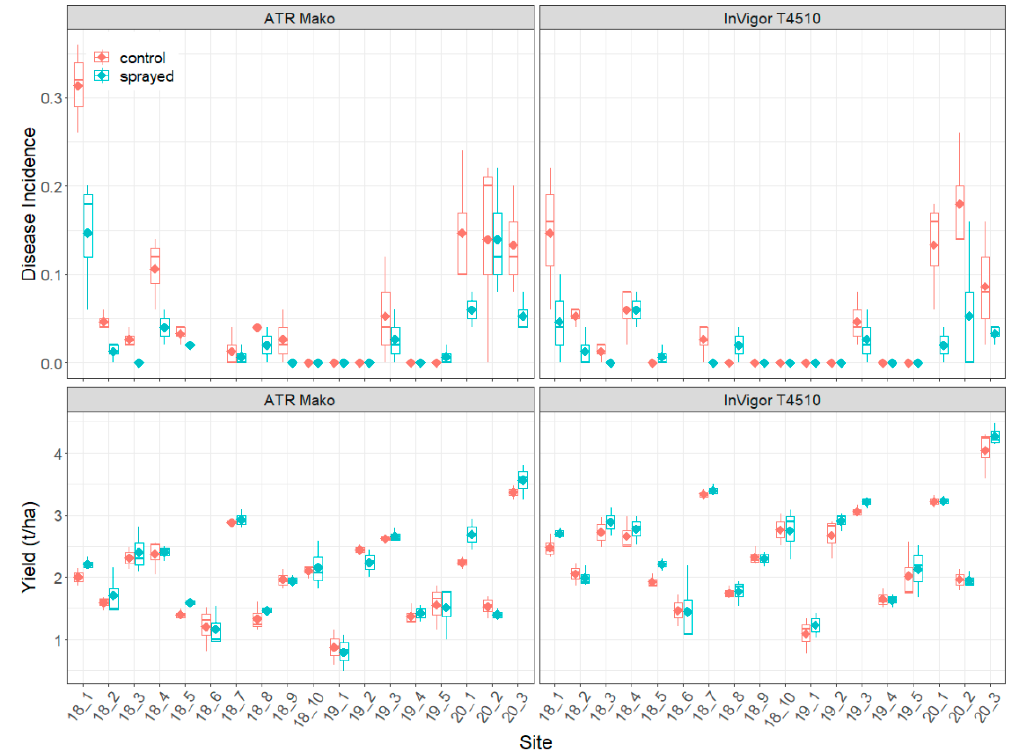
Figure 3. Disease incidence (proportion of infected plants) and final yield (t/ha) of ATR Mako and Invigor T4510 canola plants sown at 18 sites across three growing seasons (2018–2020). Two management treatments were applied: no fungicide application (control) and fungicide application at 30% flowering (sprayed). Table 3. Summary of treatment main effects and interactions on SSR disease incidence (proportion of infected plants) and canola yield (t/ha) for four varieties (ATR Bonito, Hyola 559TT, ATR Mako and InVigor T4510). Variance ratio and degrees of freedom (in brackets) are presented.